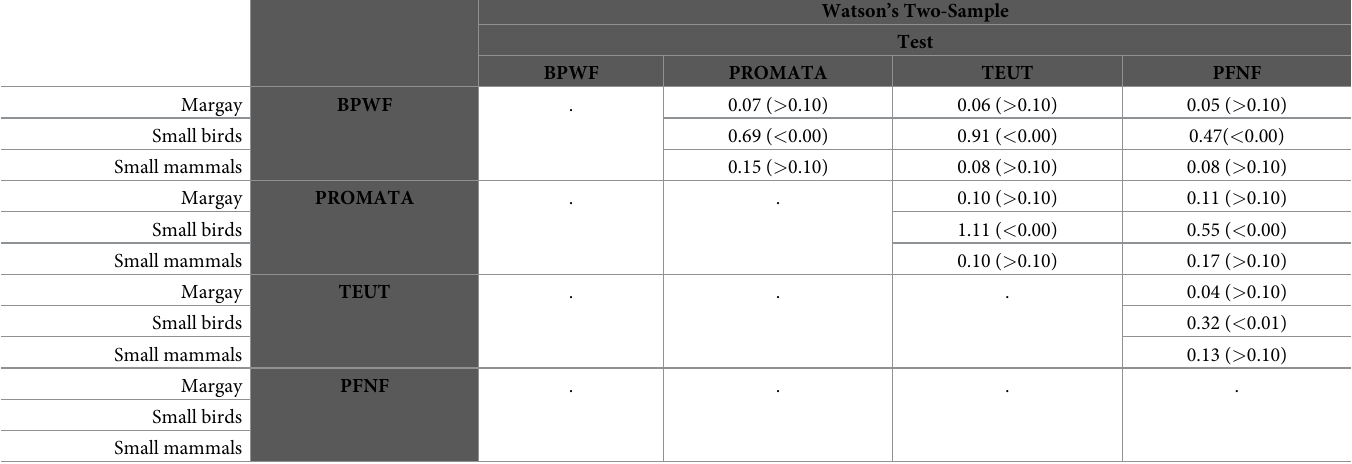
Table 5. Estimates of Watson’s Two-Sample Test of Homogeneity of margay and its potential prey; estimates (P-values).